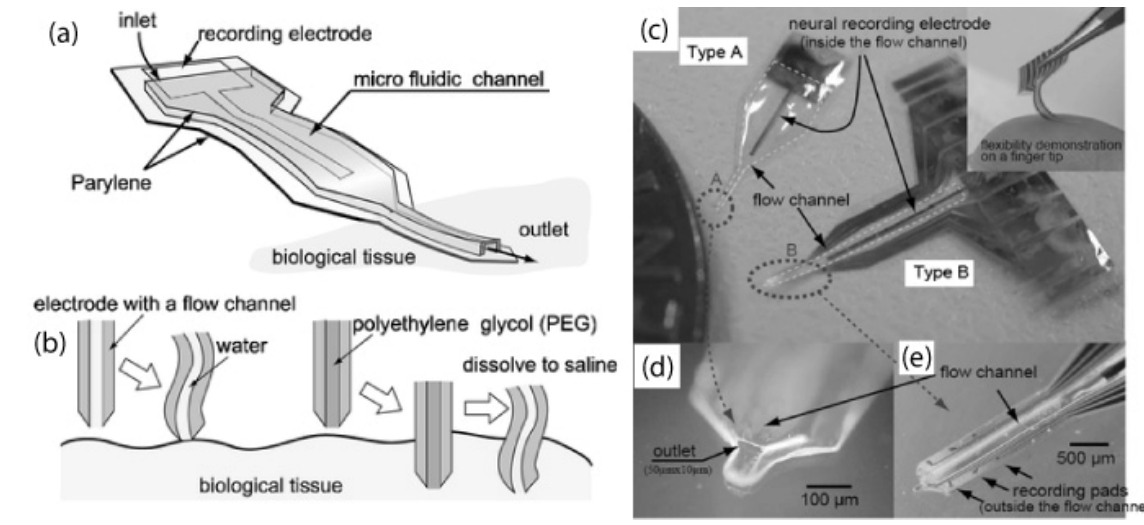
Figure 20. The concept of the neural probe. (a) The fluidic channel is used to improve the stiffness of the probe during insertion. The channel also allows drugs to be injected into the cells and the neural signals from them to be measured. (b) Compared with a channel filled with water, the channel filled with PEG allows smoother insertion; PEG dissolves after the implantation and the probe's flexibility is recovered in the tissue. Photos of the probes. (c) Type A is a single channel electrode. Type B has 6+1 recording channels (six channels are outside and one is inside the fluidic channel) and work for extracellular neural